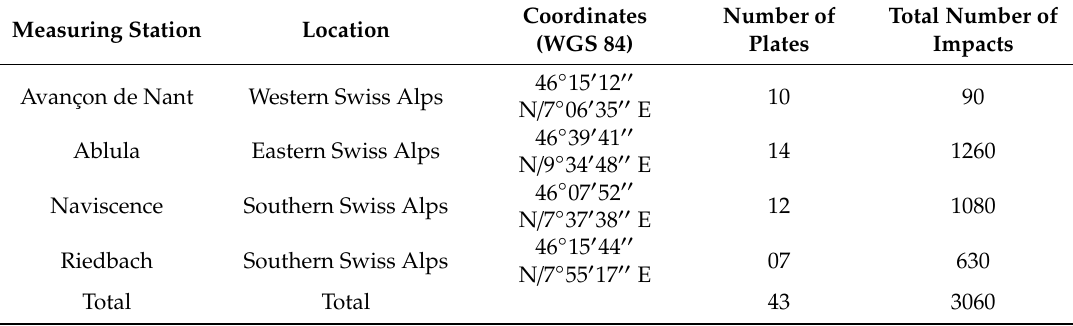
Table 4. Number of tested plates at four measuring stations where the impact experiment was conducted. The four measuring stations are all located within the Swiss Alps, at Alpine rivers that give their name to the measuring